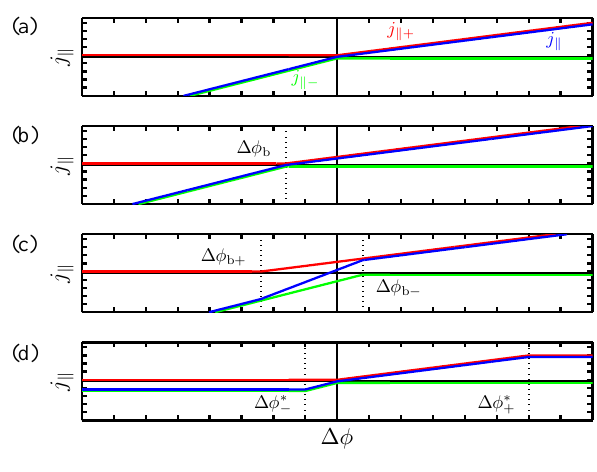
Fig. 2. Different current-voltage relations j k (1φ) for the auro- ral current system (blue), with upward (red) and downward (green) currents j k± carried by magnetospheric and ionospheric particles. (a) Current linearly proportional to 1φ for both upward and down- ward current regions. (b) Linear current-voltage relation with a bias potential 1φ b . (c) Linear relation with different bias 1φ b ± for up- and downward currents. (d) Current–voltage relation with current limits; the limit for downward currents is fairly low and starts from a small 1φ ∗ − , while the linear relation can be maintained for upward currents up to a much larger treshold 1φ ∗ +